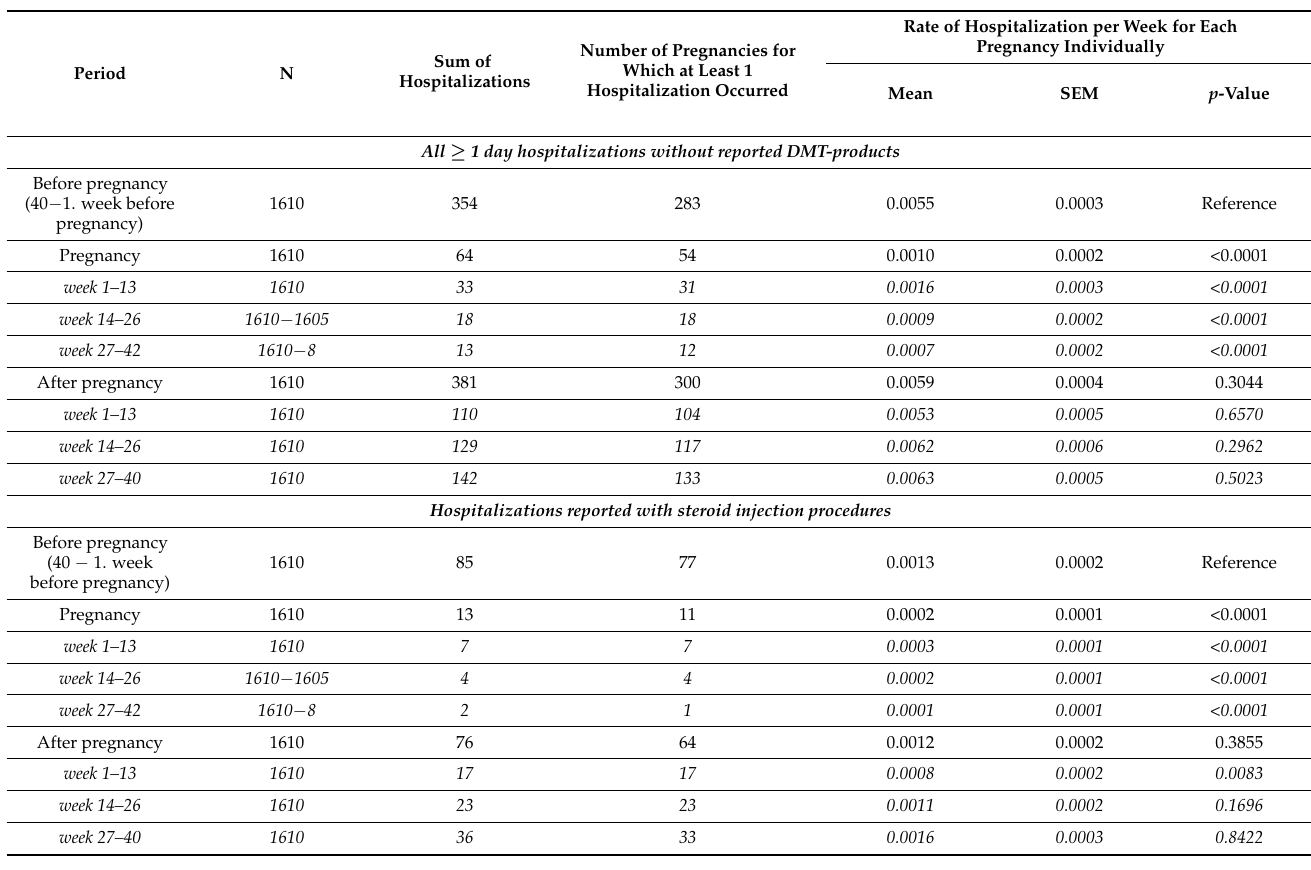
Table 3. Number of hospitalizations before, during and after pregnancy with the standard error of the mean. The weekly rate of hospitalizations for each pregnancy during and after pregnancy was compared to the rate before pregnancy using Wilcoxon tests for